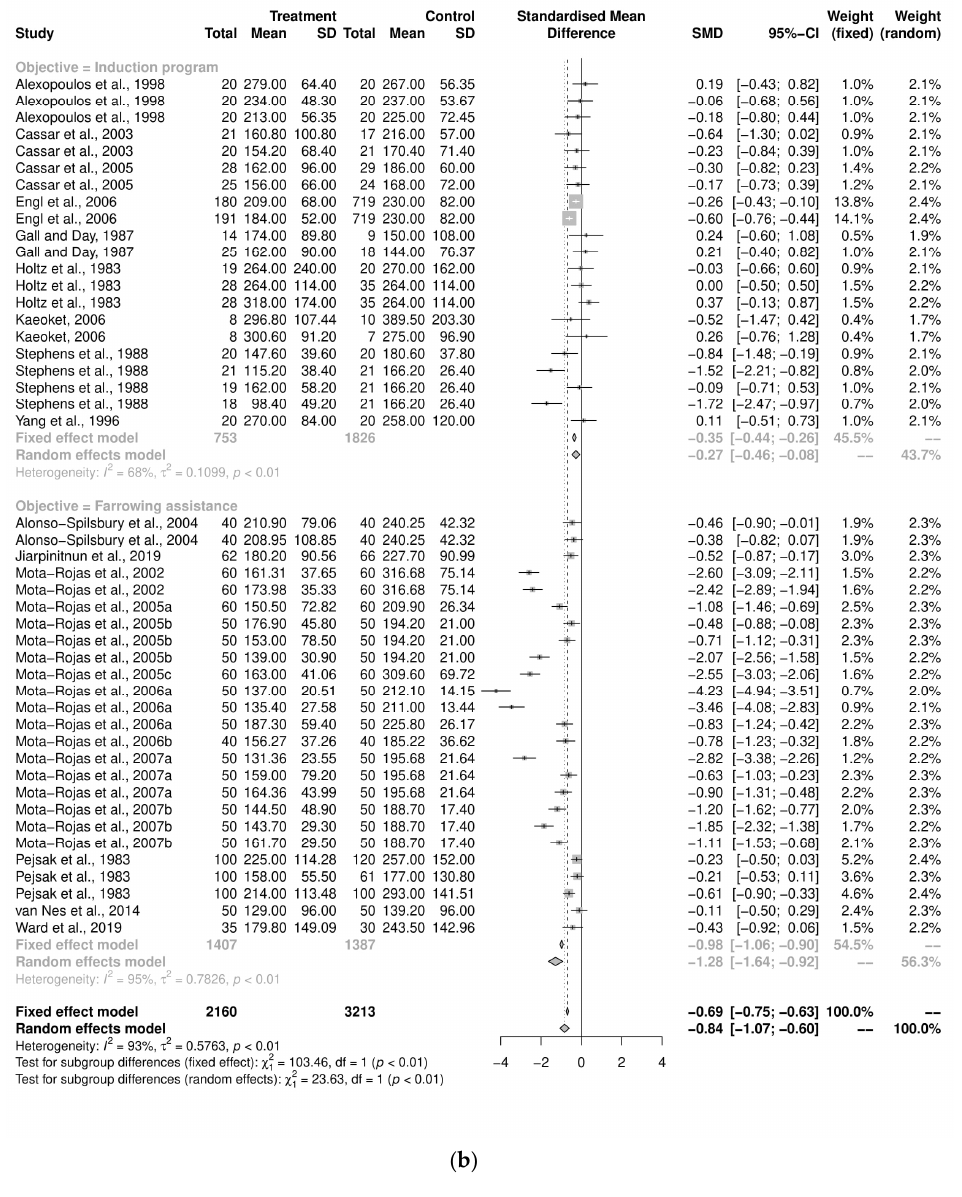
Figure 5. ( a ) Meta-analysis examining mean farrowing duration: pooled analysis [9–21,28,30,31,33]. ( b ) Meta-analysis examining mean farrowing duration: sub-group analysis by study objective (induction program and farrowing assistance [29,30–32,34–48,50,51,53].